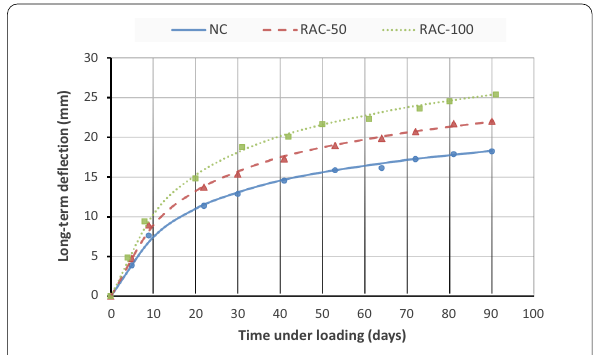
Fig. 11 Long-term